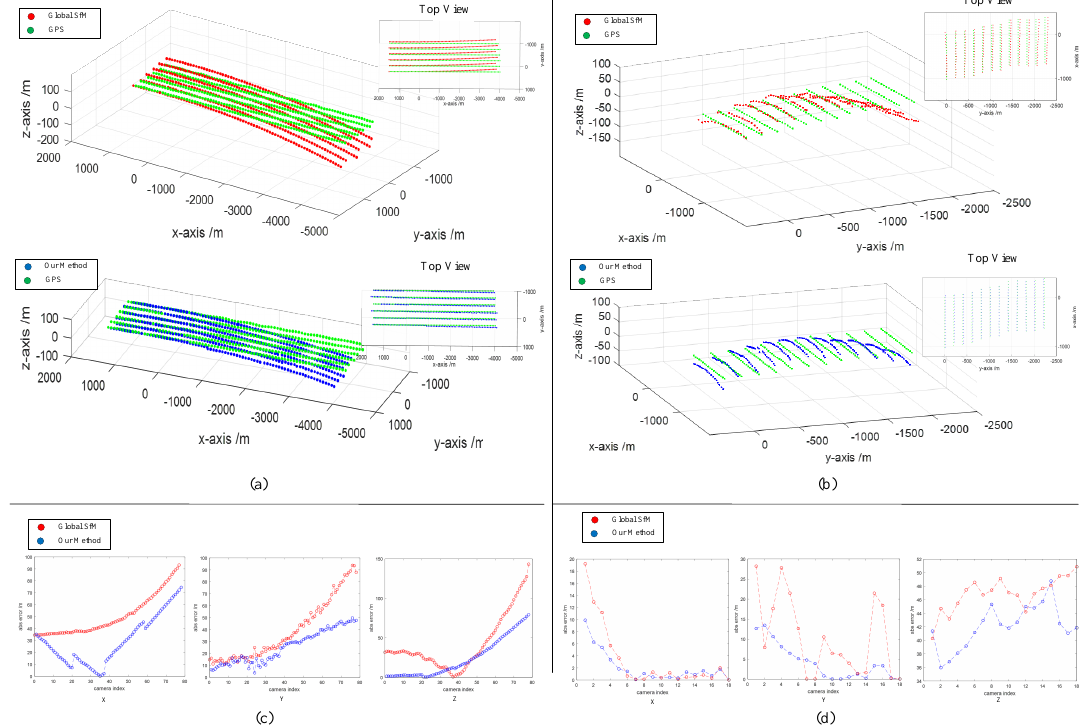
Figure 11. Experimental comparison results of the accuracy of the reconstructed camera trajectory. ( a ) and ( b ) The 3D camera trajectory comparison between the reconstructed camera trajectory and GPS ground truth on the towns dataset and the mountains dataset, respectively. ( c ) and ( d ) The absolute value of the difference between the reconstructed camera trajectory and the GPS ground truth on the X, Y, and Z axes in the towns dataset and the mountains dataset, respectively.